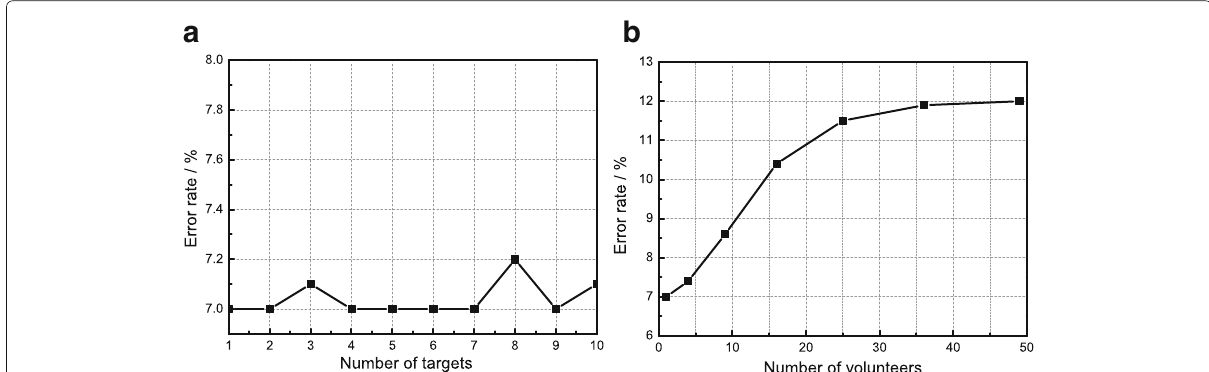
Fig. 7 a Classification error rate under a different number of target goods. b Classification error rate under a different number of